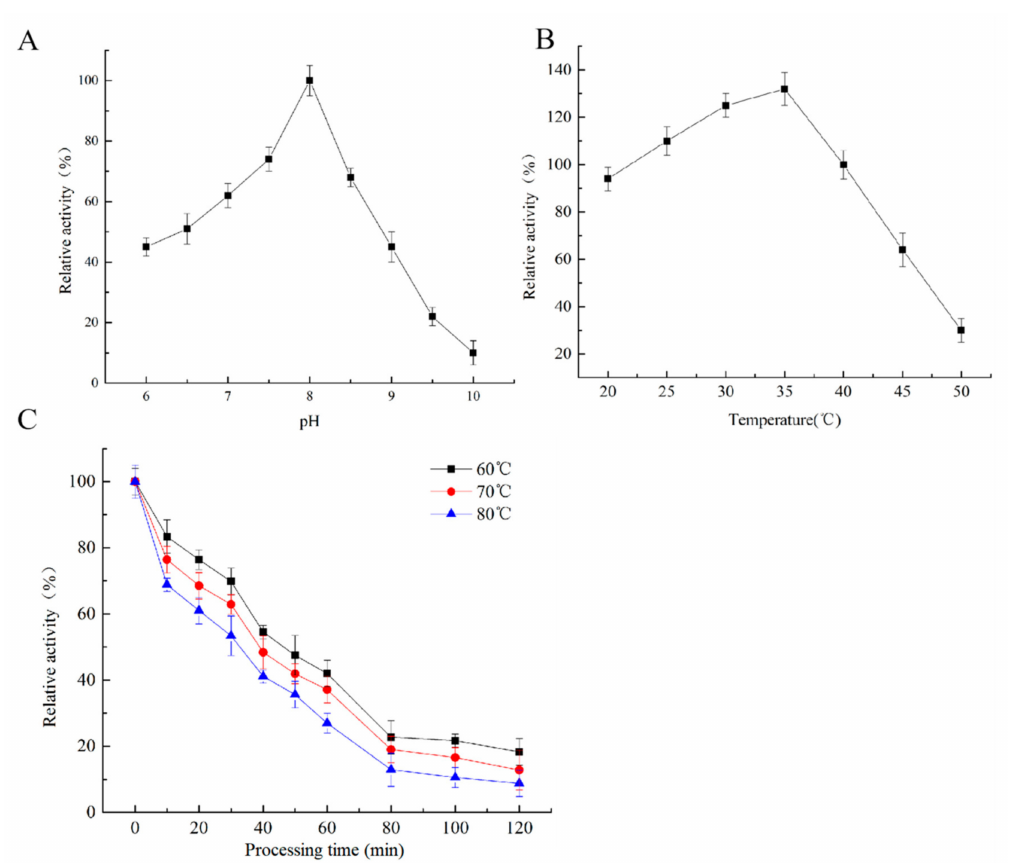
Figure 2. Characterization analysis for the YlLip2 mutant: ( A ) relative activity of the YlLip2 mutant in Tris-HCl bu ff ers with di ff erent pH values; ( B ) relative activity of the YlLip2 mutant at di ff erent temperatures; and ( C ) relative activity of the YlLip2 mutant after preincubation at 60, 70 and 80 ◦ C, respectively. Data are the mean ± standard deviation of triplicate